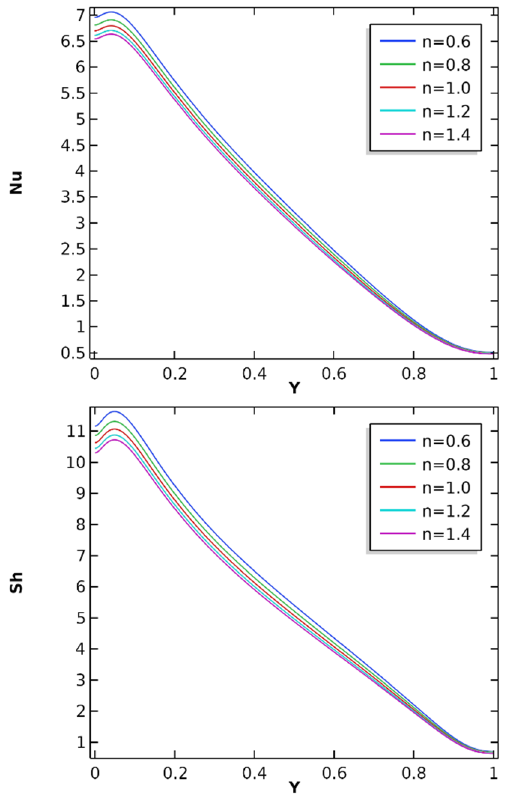
Figure 8. Variation in local Nu and Sh . Table 4. Average Nu and Sh comparison.